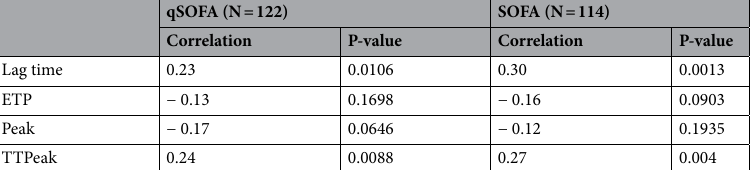
Table 4. Spearman correlation between thrombin generation and the SOFA/qSOFA ordinal scores. SOFA sequential organ failure assessment, qSOFA quick sequential organ failure assessment, Min minute, ETP endogenous thrombin potential, TTPeak time to